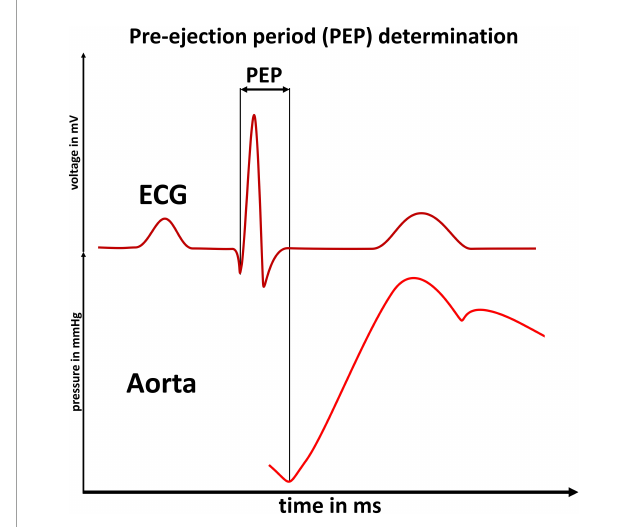
FIGURE1 Pre-ejection period determination: Illustration of the pre-ejection period (PEP) as the time delay between an ECG’s Q-wave (upper panel) and the start of blood ejection (increased flow in the aorta, lower panel). The PEP cannot be detected by ECG based measurements of the pulse-wave-velocity.